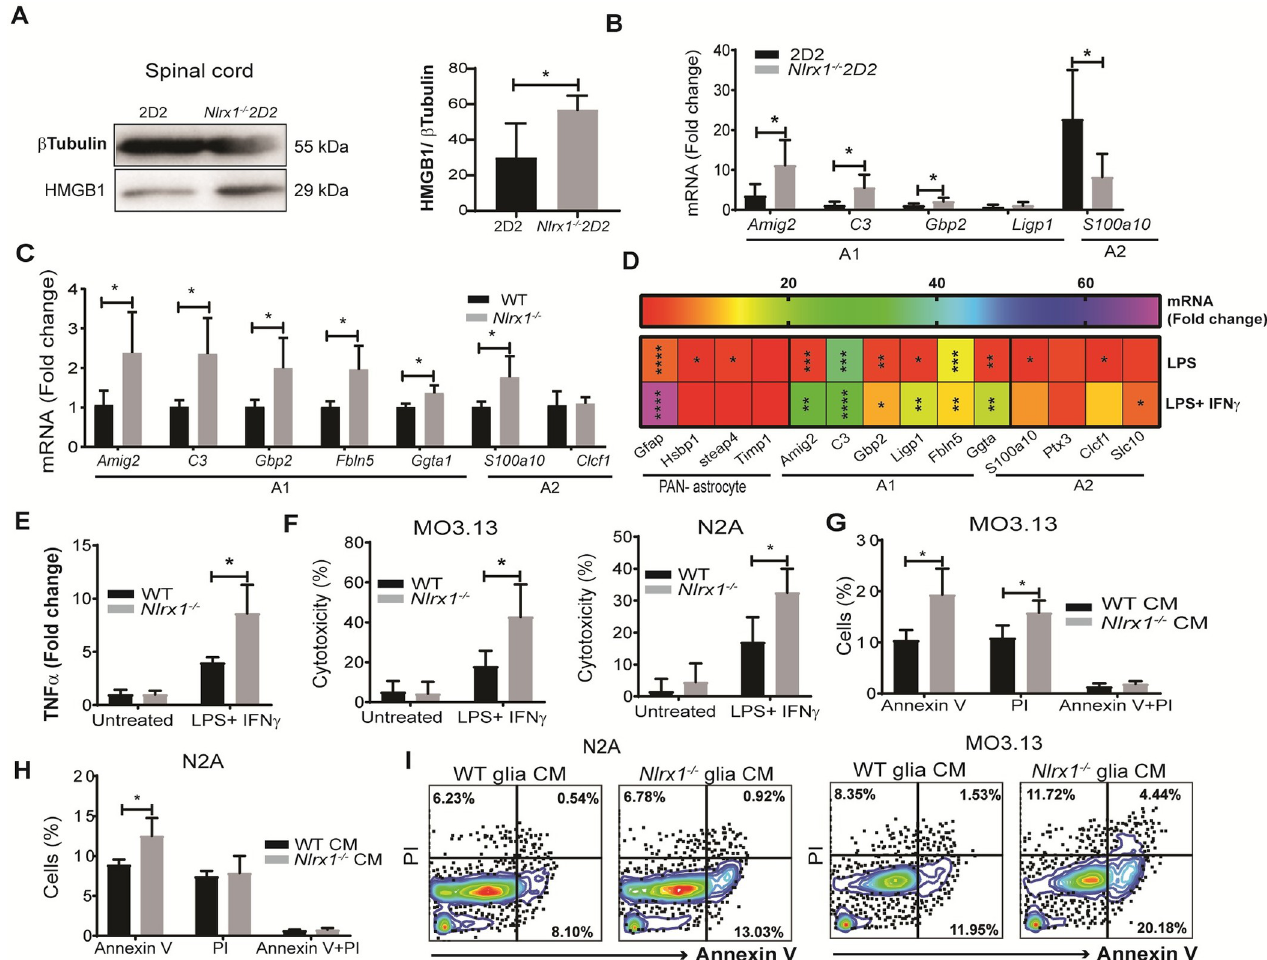
Fig 5. NLRX1 inhibits the tissue damage and generation of neurotoxic glia in the CNS at the subclinical stage of EAE. (A) The level of HMGB1 in the spinal cord of asymptomatic Nlrx1 −/− 2D2 mice compared with 2D2 mice, determined using western blot and quantified by the percentage of HMGB1 to β -tubulin ratio ( n = 6 mice per group). (B) The levels of A1- and A2-related gene expression in brain from Nlrx1 −/− 2D2 mice compared with 2D2 mice ( n = 5 mice per group). (C) The expression of A1-related genes in the brains of Nlrx1 −/− m ice compared with WT mice ( n = 5). (D) A heatmap diagram showing the fold change of mRNA levels of pan-, A1- or A2-reactive astrocyte-related genes in Nlrx1 −/− glia culture after 24 hours of stimulation with LPS (500 ng/mL) or LPS+IFN γ (10 ng/mL) compared with the corresponding WT controls ( n = 4 independent samples in each group). (E) TNF α level in the conditioned medium (CM), collected 24 hours after LPS/IFN γ treatment of glia culture and measured by ELISA ( n = 4 independent samples/group). (F) The toxicity of Nlrx1 −/− or WT glia CM on MO3.13 and N2A cells after 24 hours, measured by MTT assay ( n = 6 independent samples/group). (G) Expression of apoptosis (annexin V) and permeability (propidium iodide [PI]) markers on MO3.13 cells incubated with Nlrx1 −/− glia CM compared with WT glia CM for 24 hours ( n = 4 independent samples/group). (H) The percentage of annexin V–and PI-positive N2A cells incubated with Nlrx1 −/− glia CM compared with WT glia CM for 24 hours ( n = 4 independent samples/group). (I) Representative flow cytometry plots used for the quantification of annexin V and PI positivity of MO3.13 and N2A cells. All the data are presented in mean ± SD. � P � 0.05, �� P � 0.01, ��� P � 0.001, determined by the two-tailed Student t test. Underlying data can be found in S1 Data. CM, conditioned medium; CNS, central nervous system; EAE, experimental autoimmune encephalomyelitis; HMGB1, high mobility group box 1; IFN γ , interferon gamma; LPS, lipopolysaccharide; MTT, 3-(4,5-Dimethylthiazol-2-yl)-2,5-Diphenyltetrazolium Bromide; NLRX1, nucleotide-binding, leucine-rich repeat containing X1; PI, propidium iodide; TNF α , tumor necrosis factor alpha; WT, wild-type.